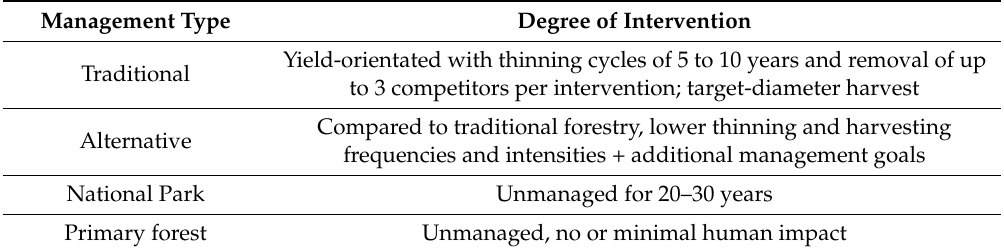
Table 2. Degree of intervention for traditionally managed and alternatively managed beech forests, National Parks, and primary